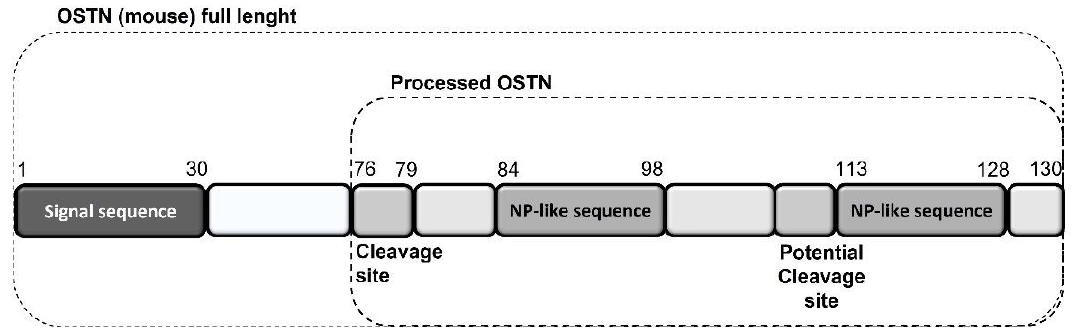
Figure 1. Mouse musclin/OSTN structure and NP-like sequences.